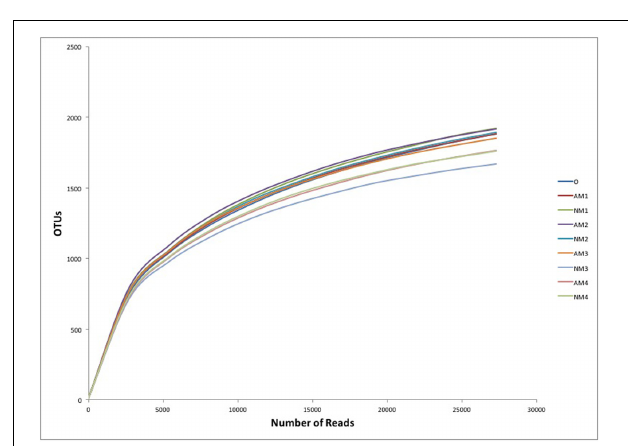
FIGURE 3 | Rarefaction curve of soil bacterial OTUs clustered at 97% sequence identity across different soil samples. Abbreviations: AM represents the treatment inoculated with arbuscular mycorrhizal fungi, NM represents the uninoculated treatment, while O stands for the original soil collected from the forest. Different numbers (1, 2, 3, and 4) represent the different sampling times (T 90 , T 120 , T 150 , and T 180 ,